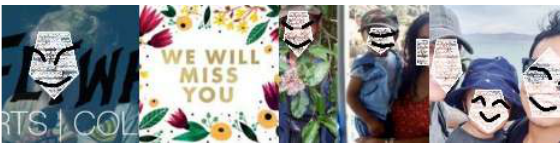
Fig. 5 Examples of technical score prediction by the MobileNet (the score goes up from left to right).